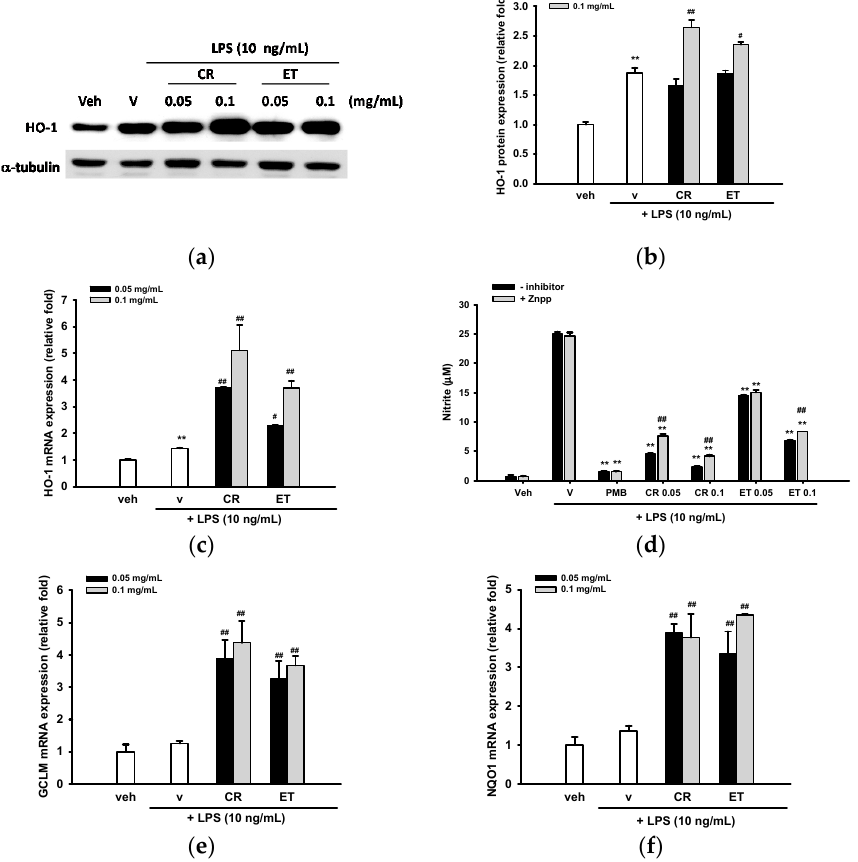
Figure 5. Induction of Nrf2 target gene expression by ethanol extracts of C. rutidosperma (CR) and E. thymifolia (ET). ( a ) BV2 cells were cultured with indicated reagent for 16 h and level of HO-1 expression was determined by Western blotting; ( b ) Band intensities were quantified by ImageJ software and indicated as relative fold of HO-1/ α -tubulin; ( c , e , f ) HO-1, GCLM and NQO-1 mRNA expression levels were determined at 4 h after LPS treatment by RT-Q-PCR. Data are represented as the mean ± SD ( n = 3). Statistical differences are presented ** p < 0.01 compared with the vehicle control (without LPS) and # p < 0.05; ## p < 0.01 compared with the LPS-treated vehicle; ( d ) BV2 cells were pre-treated with Znpp (5 µM) for 30 min, followed by PMB (10 µg/mL), CR or ET (0.05 and 0.1 mg/mL) treatment for further 30 min, prior to LPS (10 ng/mL) challenge for 20 h. NO production was determined by the Griess reagent. Data are represented as the mean ± SD ( n = 3). Statistical differences are presented ** p < 0.01 compared with the LPS-treated vehicle and ## p < 0.01 compared with relative Znpp-untreated group.